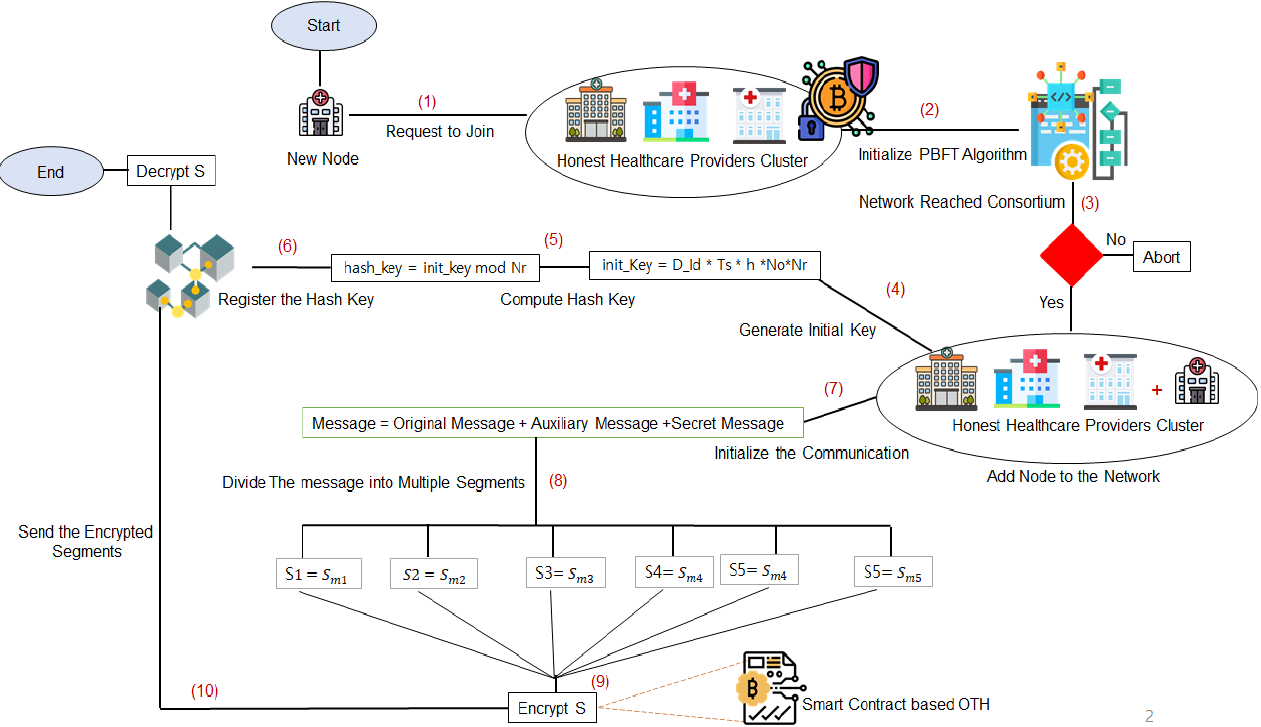
Figure 2. Methodology of the Proposed Framework.